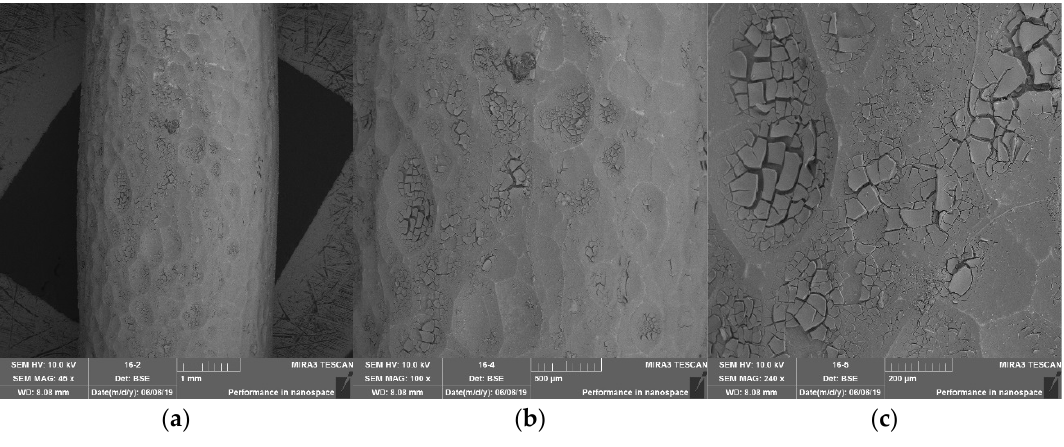
Figure 13. SEM micrographs of the surface of a sample containing five layers of protective coating applied by sequential immersion in tetraethoxysilane and ammonia. ( a ) zoom ×45; ( b ) zoom ×100; ( c ) zoom ×240.